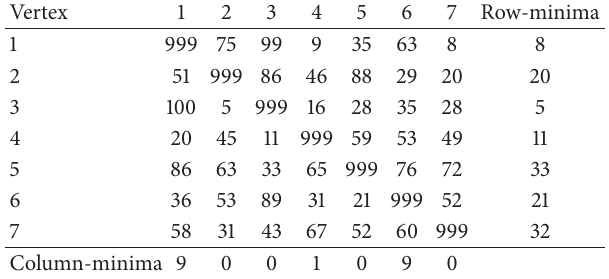
Table 1: The cost matrix with row-minima and column-minima.